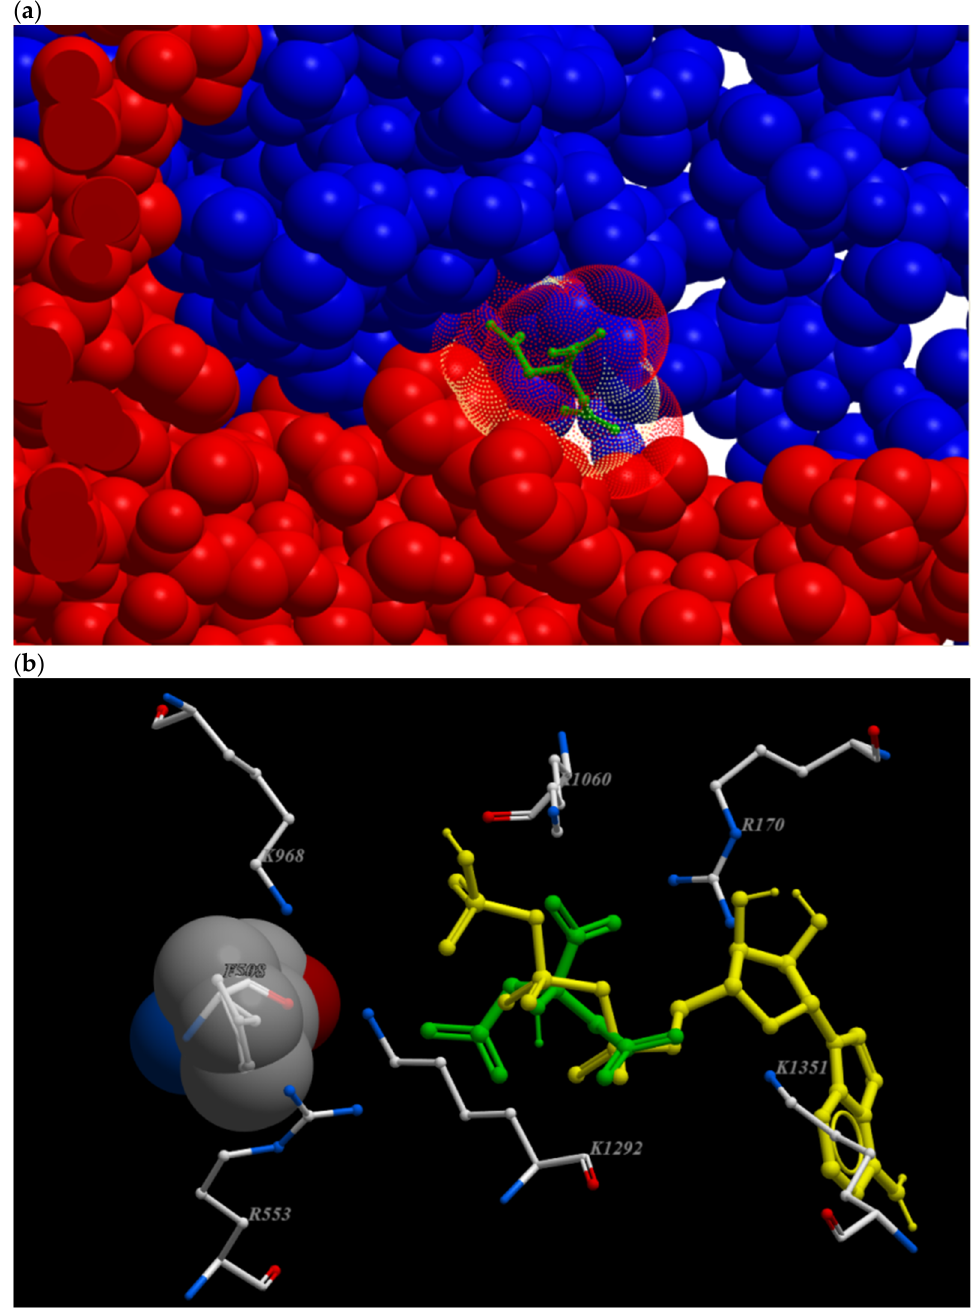
Figure 1. Binding site of citrate and ATP to the open conformation of CFTR. ( a ) Citrate (green) binds to a cleft between the nucleotide binding domains NBD1 (red) and NBD2 (blue). ( b ) Citrate (green) and ATP (yellow) bind to basic amino acid residues in the vicinity of F508.